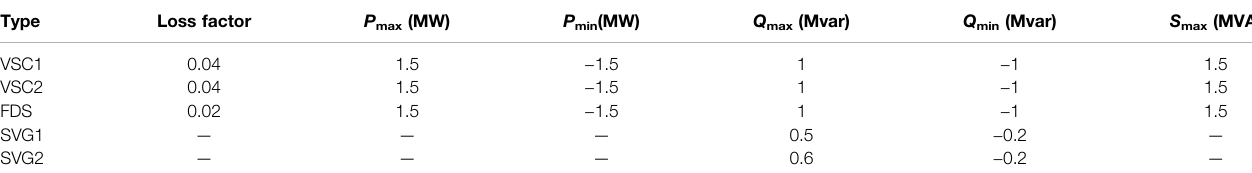
TABLE 1 | The parameters of VSC, FDS and SVG.